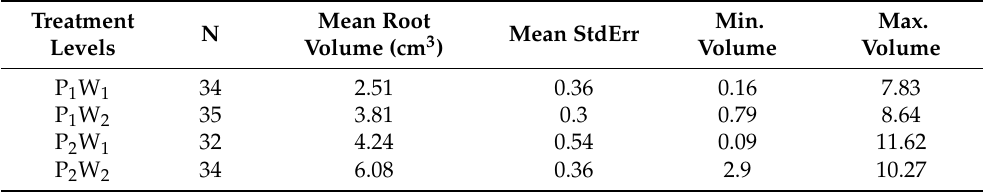
Table 13. Effects of phosphorus–water treatments on root volume (cm 3 ) of common bean.